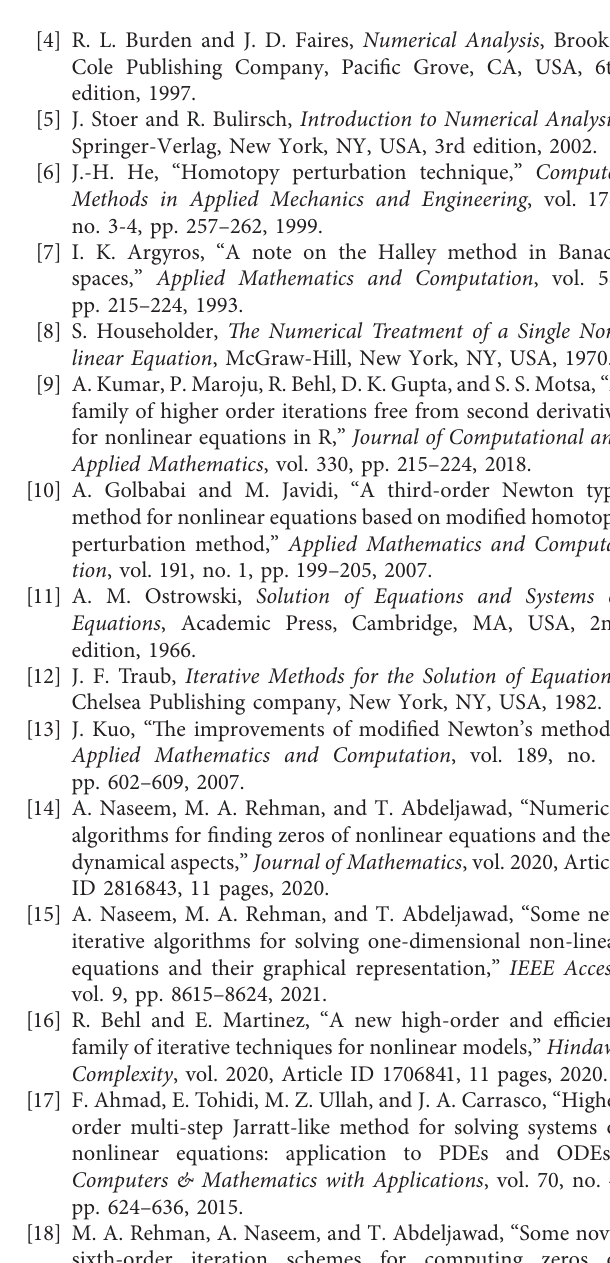
Figure 5: Polynomiographs related to the complex polynomial q (d) Algorithm